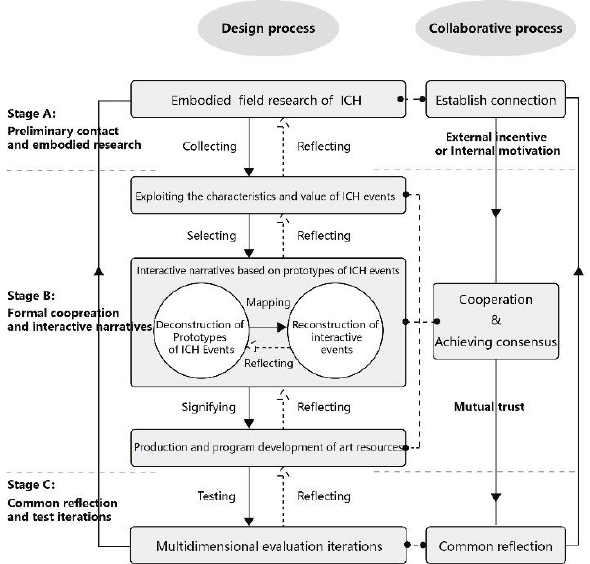
Figure 1 . Co-design Process Model of Digital Presentation of ICH. Source: